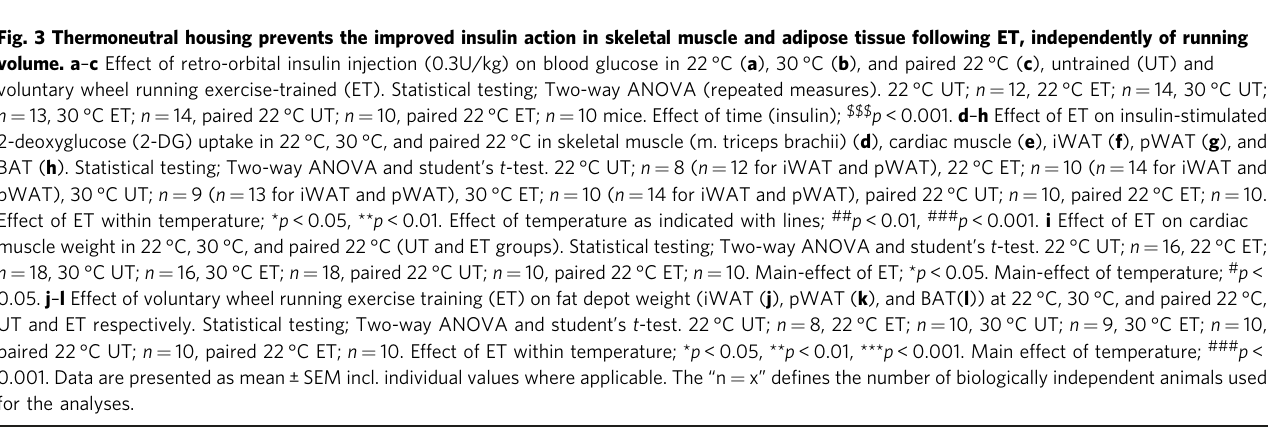
Fig. 3j, pWAT; − 40%, Fig. 3k, and BAT; − 15%, Fig. 3l). iWAT (Fig. 3j) and pWAT (Fig. 3k) mass were unchanged by housing temperature, while BAT amount was doubled in thermoneutrally housed mice (Fig. 3l) supporting a recent study 20 .